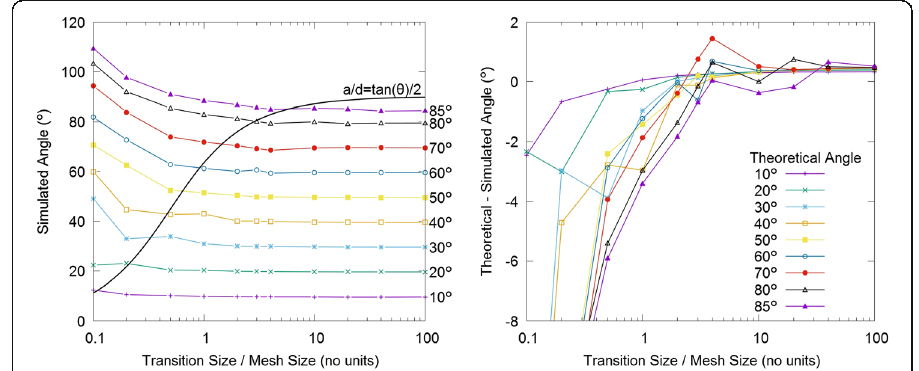
Fig. 11 Left : plot of contact angles calculated via the two-point method as a function of the mesh density and theoretical sharp interface angle for a transition size of 0.1 μ m. Right : difference between the theoretical and simulated contact angles from the figure to the